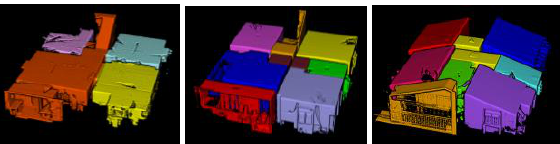
Figure 3. Point cloud of the three storeys of the building; each rooms has a different color.